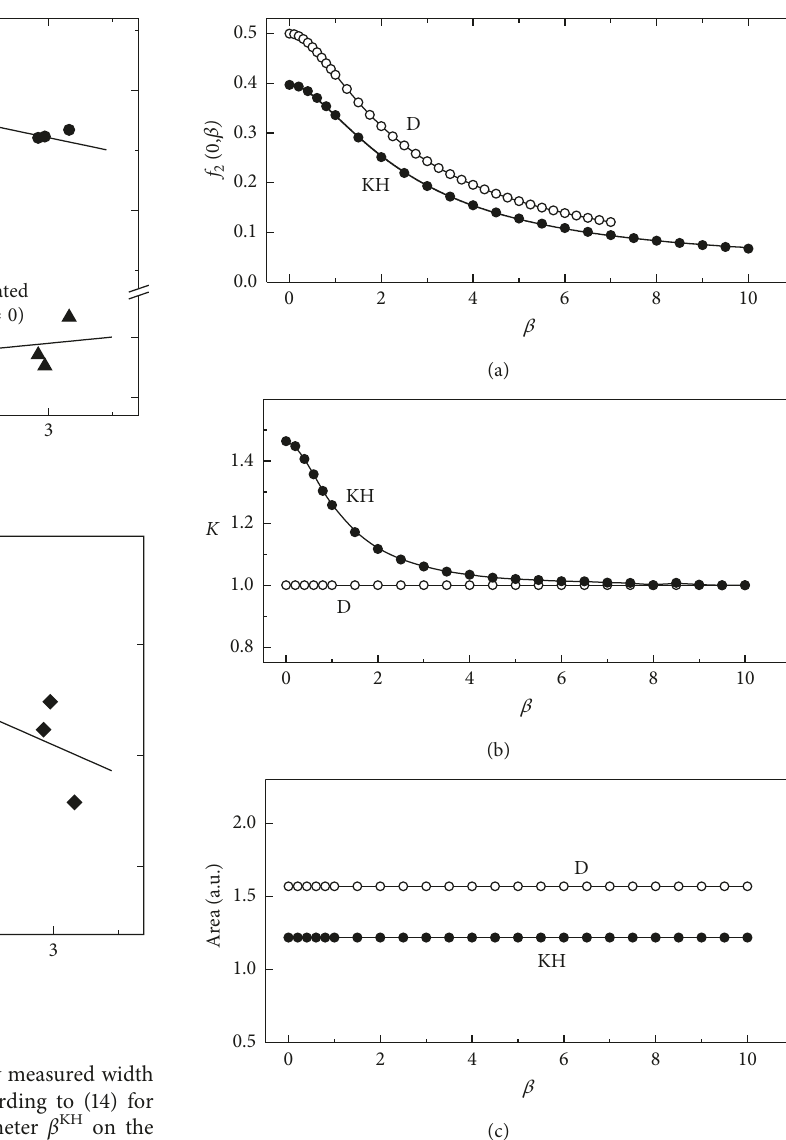
on the ΚΗ relaxation component f KH 2 (0, β ) of the KH peak (the solid line is the approximation by (27)), (b) the ratios K of the derivatives at the inflection points on the left and right sides of the KH peak (30), and f x, β dx under the peak. Filled symbols refer to the (c) the area 2 KH peak; open symbols refer to the Debye ∞ −∞ (cid:6)